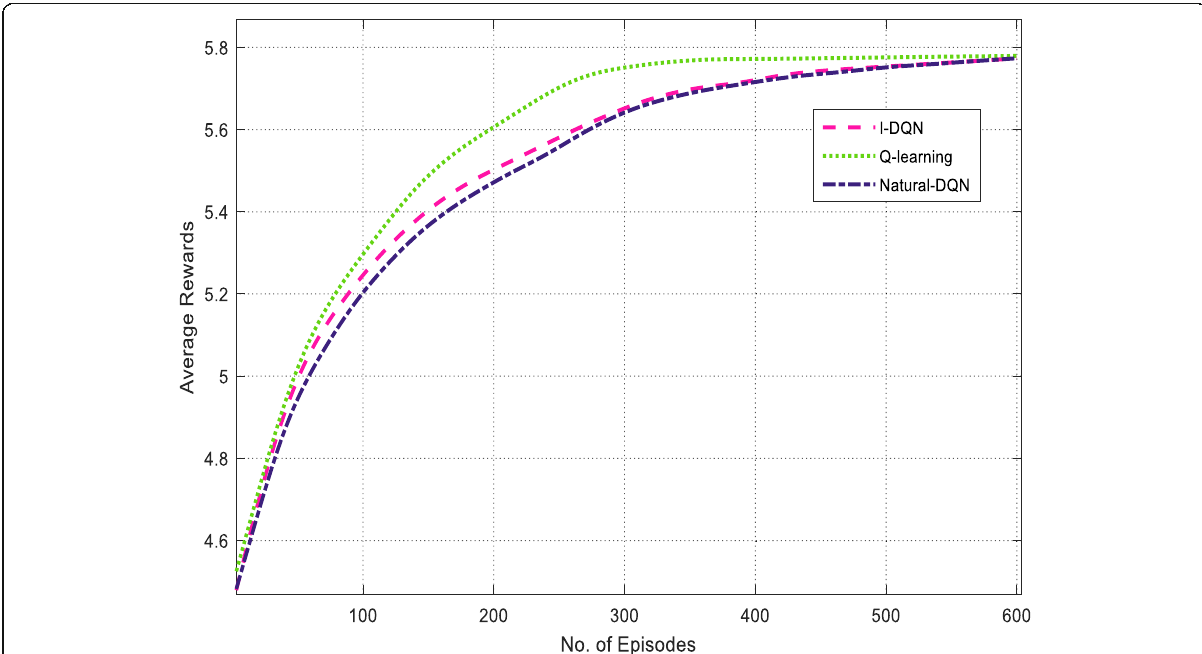
Fig. 7 Average rewards variation vs. no. of Episodes. This figure shows the average reward of the agent received from the environment varies with the number of episodes for the three algorithms, I-DQN, Q-learning, and Natural-DQN, in the scenario of 3 link failures and 15 affected